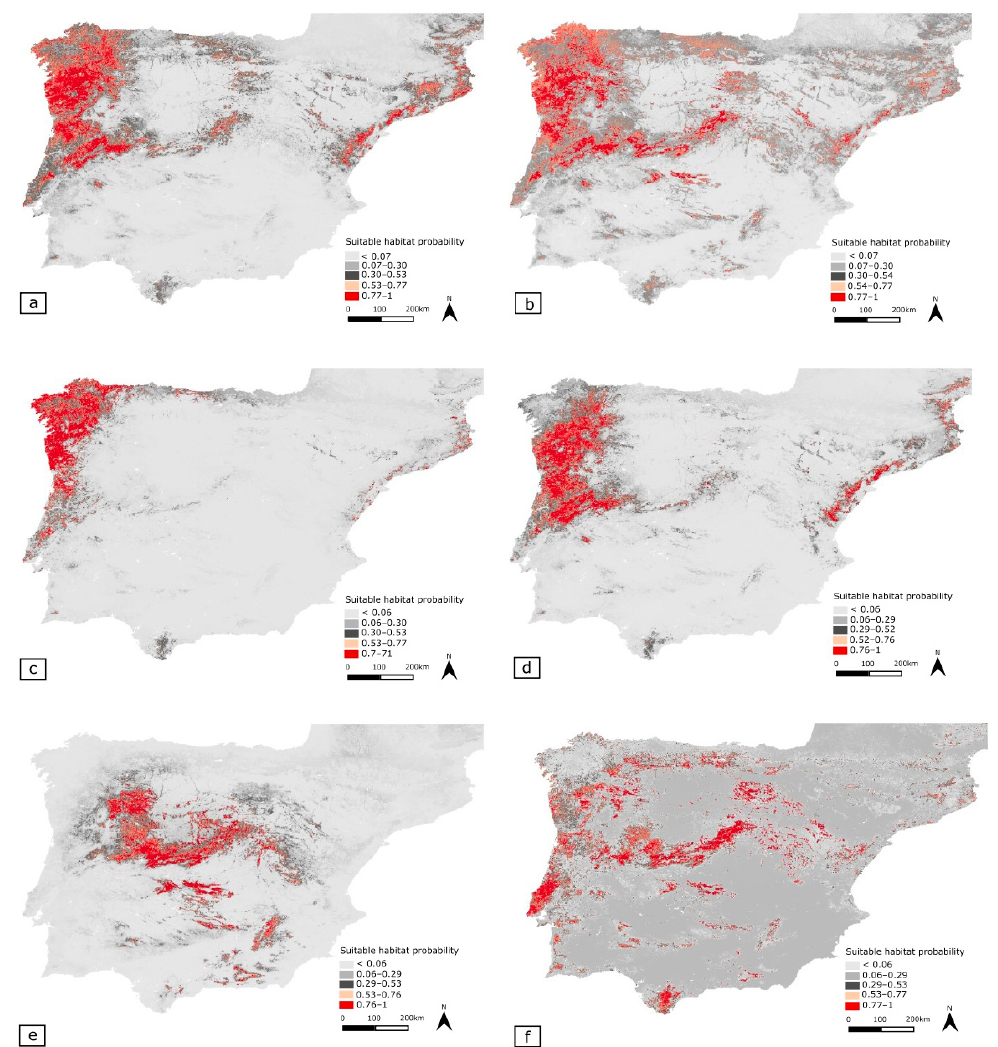
Figure 5. Maps representing the predicted habitat suitability, generated from the ensemble of ten models implemented on biomod 2 workflow. Each map represents either one of the two approaches for developing models through pooled ( a , b ) or individual species records ( c – f ). These sets are: ( a ) Merged Species Dataset including all nine species records (MSD), ( b ) most phylogenetically related cluster (PRC) of species, ( c ) Tachydromia lusitanica , ( d ) T. ebejeri , ( e ) T. semiaptera and ( f ) T. iberica . Colour represent habitat suitability value, with light grey corresponding to low suitability, red with high